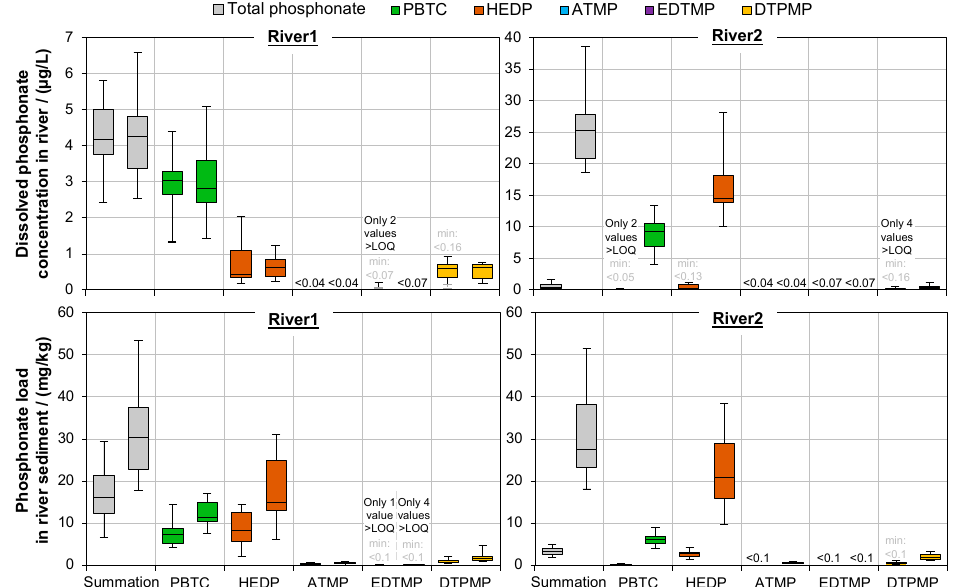
Figure 3. Boxplots (minimum, first quartile, median, third quartile, and maximum) of the concentrations of dissolved phosphonates ( top ) and phosphonate loads of sediments ( bottom ) in the two investigated rivers before ( left boxplot ) and behind the WWDs ( right boxplot ). LOQ: limit of